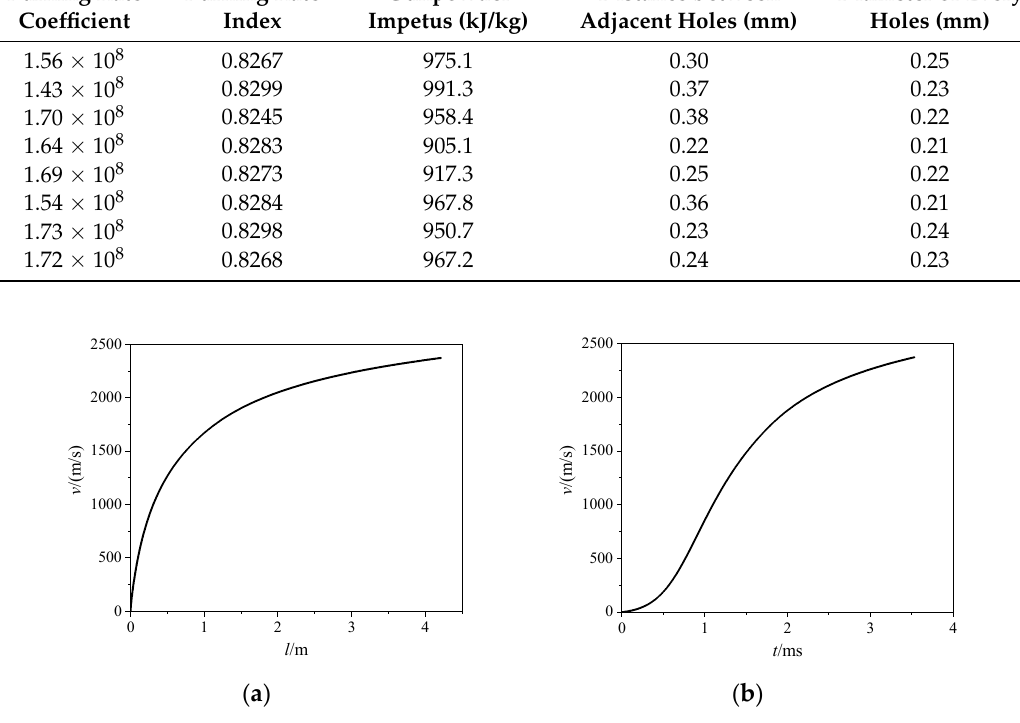
Figure 8. Velocity curve of the projectile in the tube. ( a ) v-l ; ( b ) v-t.